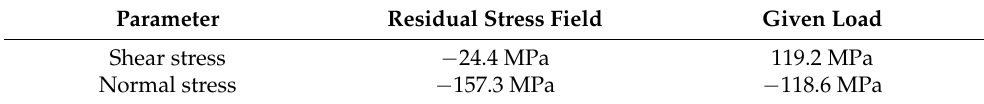
Table 5. The stress components of the critical plane from the residual stress and the given load.